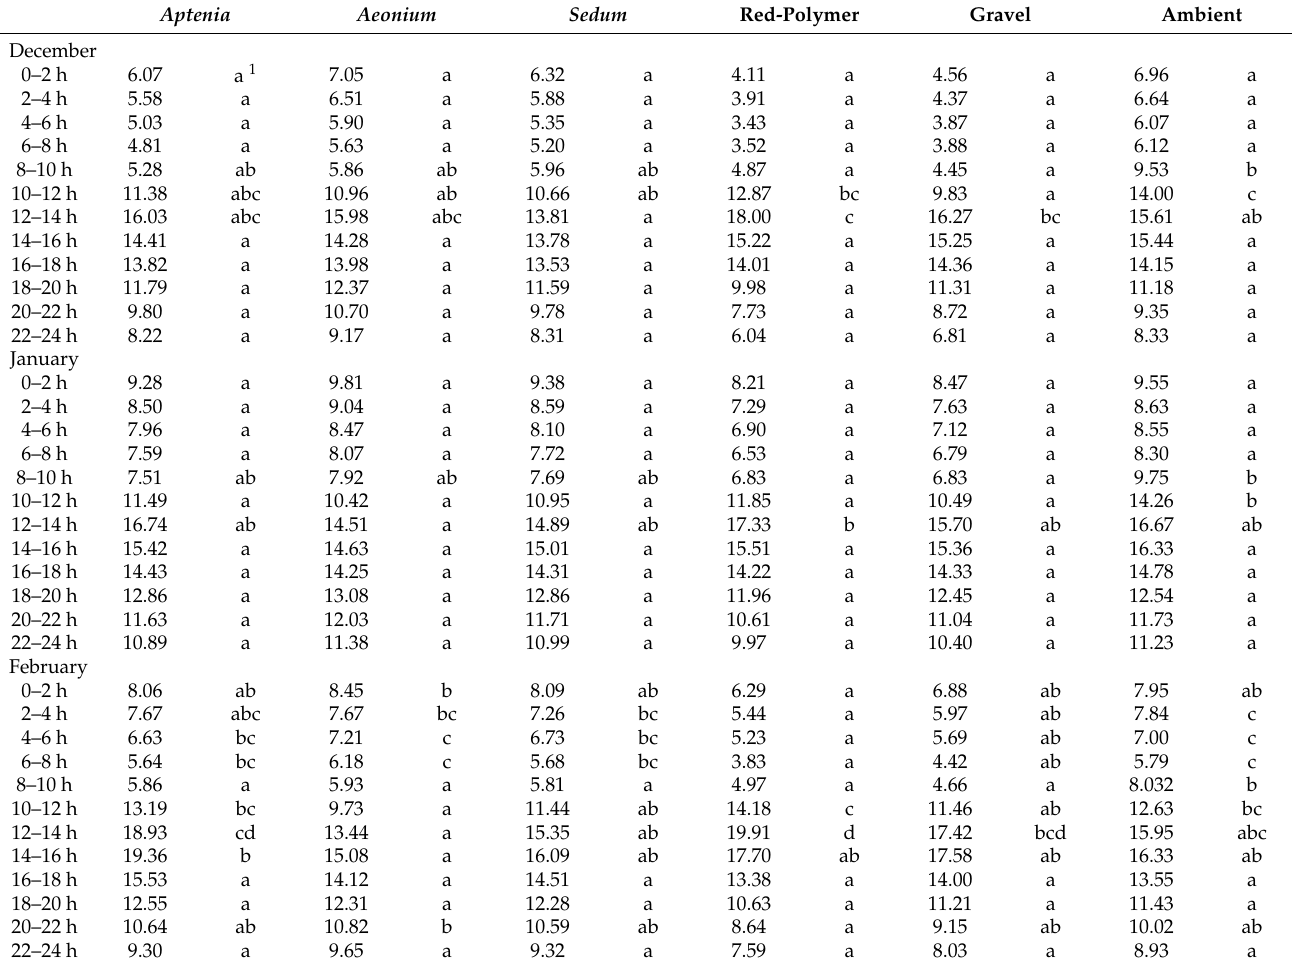
Table 3. Average temperatures ( ◦ C) every 2 h-periods during the day ( n = 5 days) in